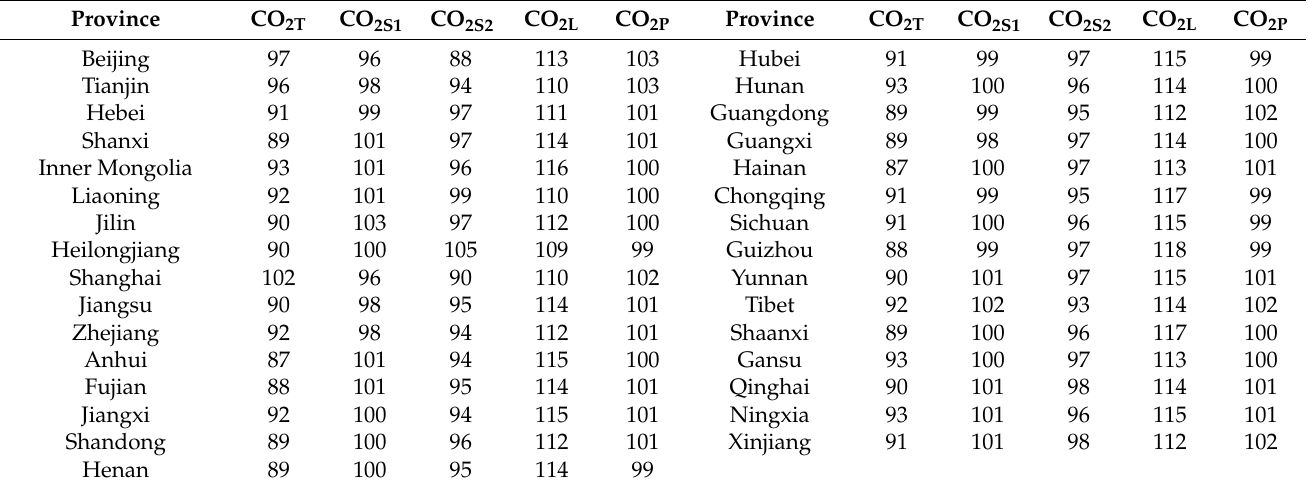
, 𝐶𝑂 (cid:2870)(cid:3020) ,𝐶𝑂 (cid:2870)(cid:3013) , (cid:3117) (cid:3118)